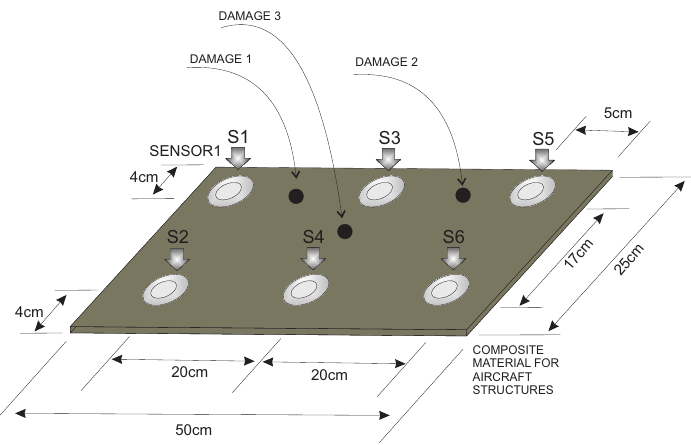
Figure 29. Composite plate instrumented with six piezoelectric